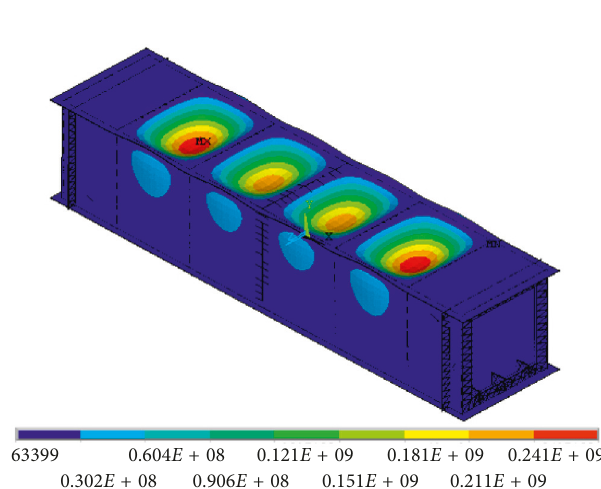
Figure 15: The von Mises stress nephogram of the wide girder (Pa).